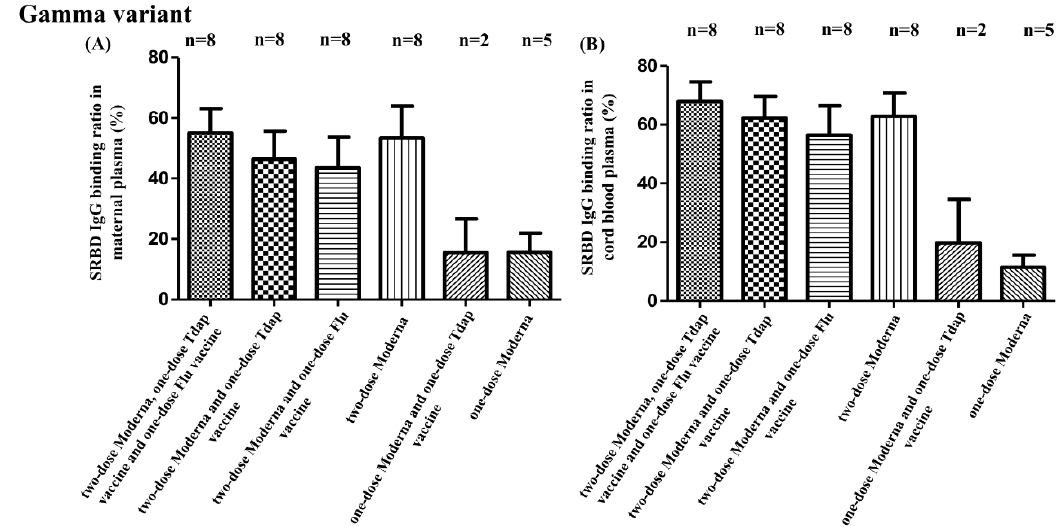
Figure 3. ( A ) SRBD IgG binding ratio against Gamma variants from maternal plasma in different vaccine combinations. ( B ) SRBD IgG binding ratio against Gamma variants from neonatal cord blood in different vaccine combinations. Tdap vaccine, tetanus toxoid, reduced diphtheria toxoid, and acellular pertussis vaccine; flu vaccine, influenza vaccine.